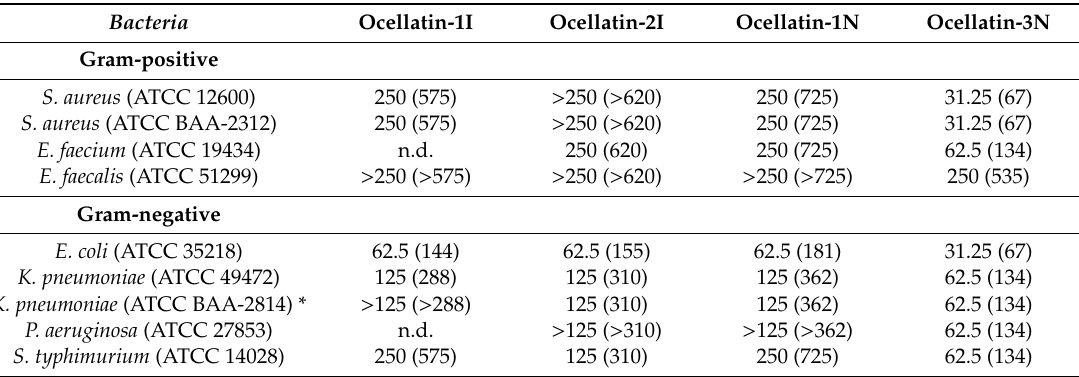
Table 2. Minimum inhibitory concentrations in µ M ( µ g / mL) of synthetic replicates of ocellatins isolated from skin secretions of L. insularum and L. nesiotus against reference and antibiotic-resistant strains of Gram-positive and Gram-negative bacteria.